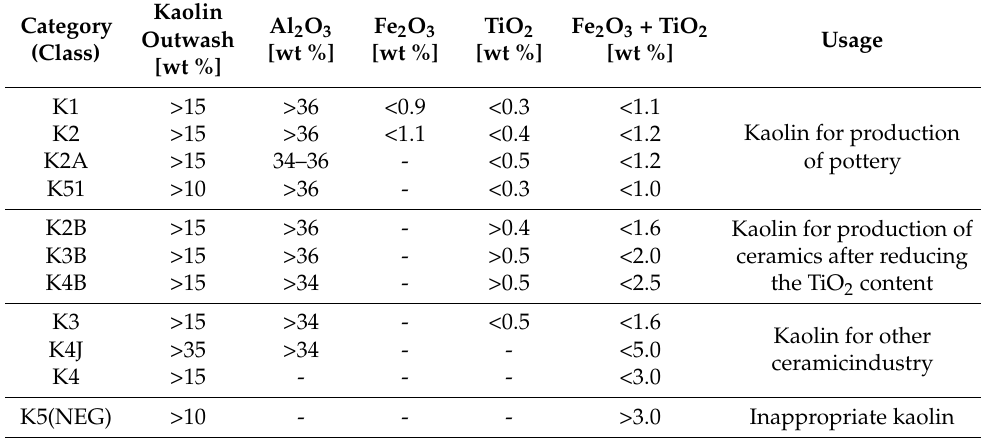
Table 1. Categorization of ceramic kaolin in the Karlovy Vary region [21].